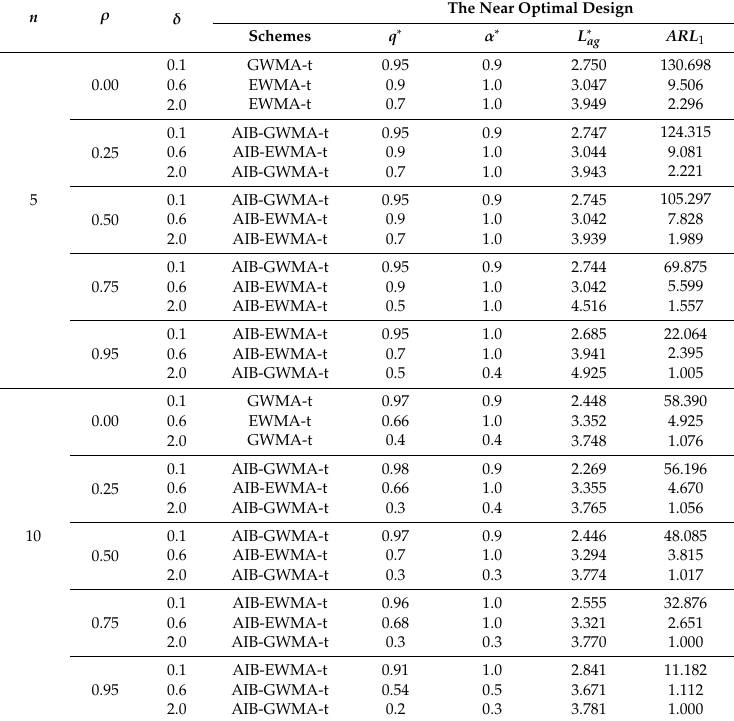
Table 4. The near optimal parameters under various process mean shifts at ARL 0 ≈